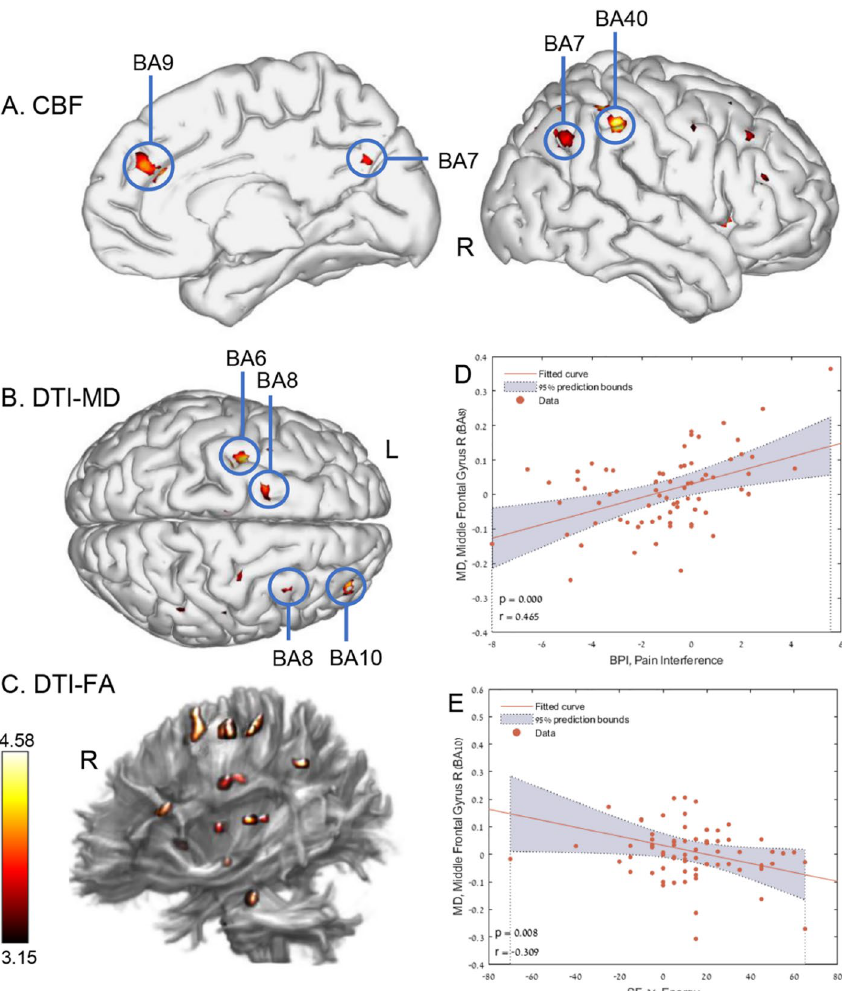
Figure 2. Brain regions with significant post-hyperbaric oxygen therapy changes compared to control. Group- by-time interaction ANOVA model in: ( A ) cerebral blood flow (CBF) in GM, p < 0.0005, uncorrected, ( B ) mean diffusivity DTI-MD in GM, p < 0.002, uncorrected, ( C ) fractional anisotropy DTI-FA in WM, p < 0.002, uncorrected. ( D ) significant correlation between pain interference score and the right middle formal gyrus MD (BA8). ( E ) significant correlation between the energy score and the right middle frontal gyrus MD (BA10). r is Pearson’s correlation coefficient. The 95% prediction interval is presented in the shaded area. CBF cerebral blood flow, MD mean diffusivity, FA fractional anisotropy, GM gray matter, WM white matter, R right, L left, BA Brodmann area. ( A ) and ( B ) brain images were created using BrainNet Viewer software (http:// www. nitrc. org/ proje cts/ bnv/) 43 . ( C ) Brain image was created using ExploreDTI software (https:// www. explo redti. com/) 44